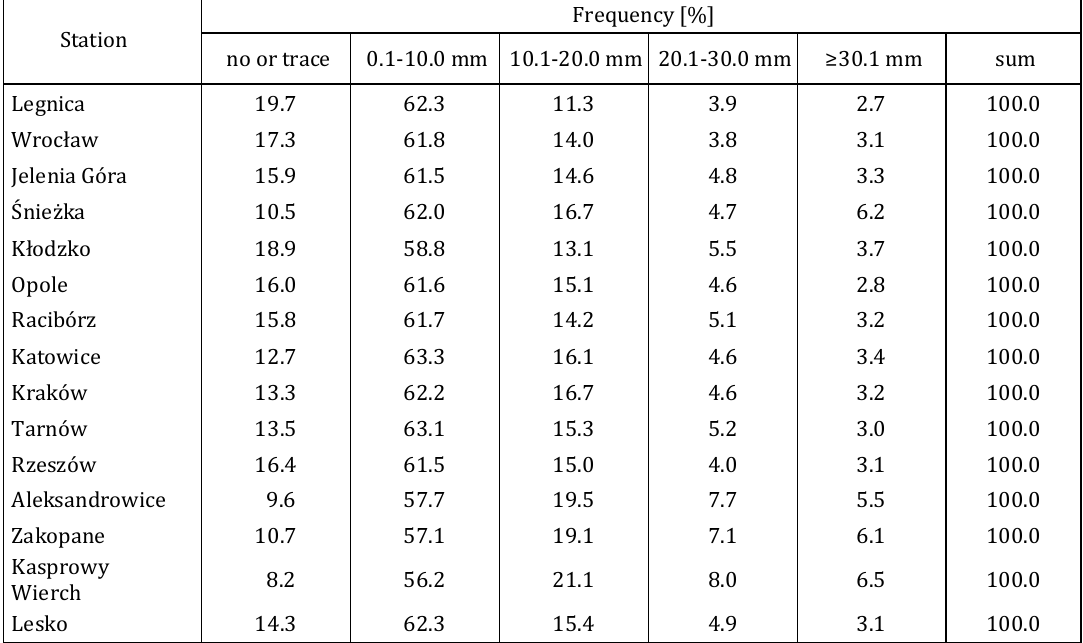
Table. 3. Frequency [%] of certain daily sums of precipitation occurrence on the days with thunderstorm in the period 1951-2010